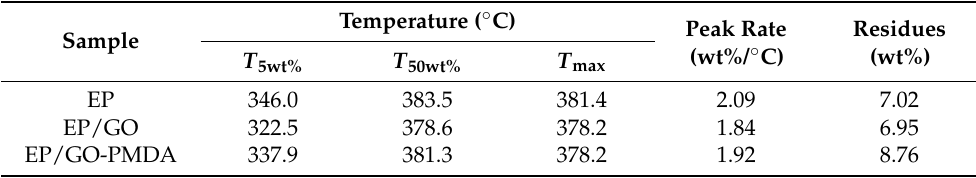
Figure 7. TGA ( a ) and DTG ( b ) curves of EP, EP/GO, and EP/GO-PMDA. Table 1. TGA data of EP, EP/GO, and